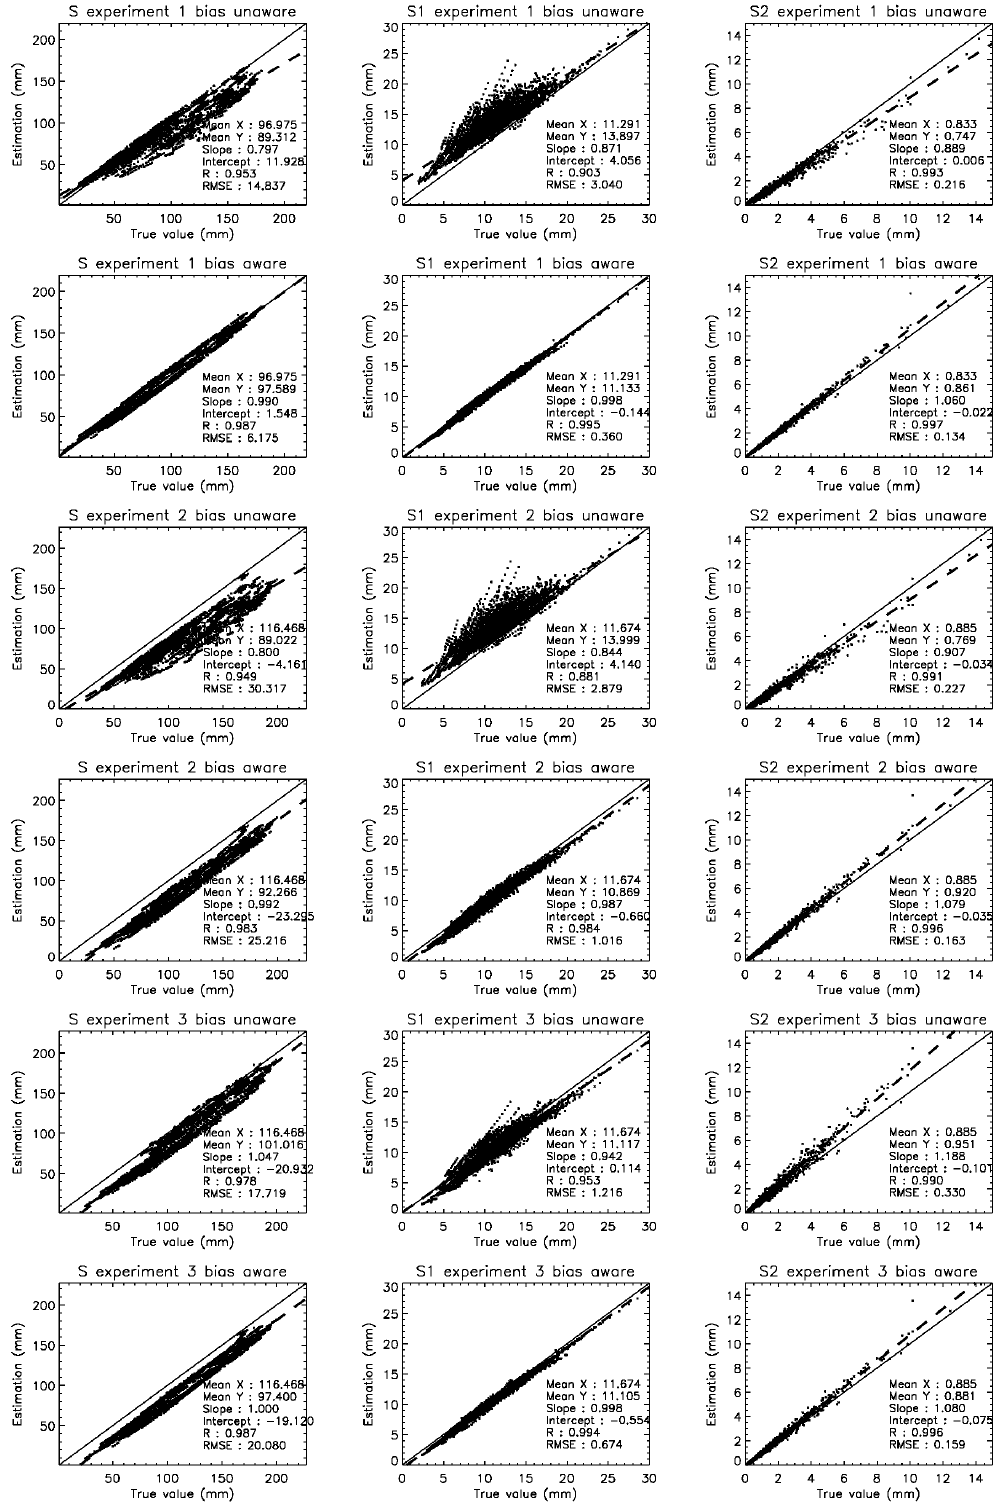
Fig. 9. Comparison of the estimated storages obtained using the bias-aware and a bias-unaware EnKF for the sinusoidal observation bias experiment. The dashed lines are the regression lines; the solid lines the 1:1 line. Synthetic true values are in x axis; estimations in y axis. The top, middle, and bottom two rows show the results of experiments 1, 2, and 3, respectively. The first, second, and third column show the results for S , S 1 , and S 2 ,